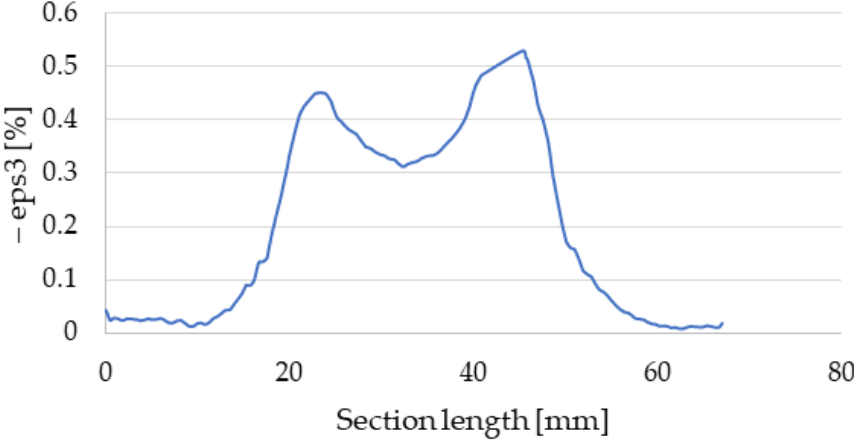
Figure 16. S2 Thickness reduction values with P7/SC2 combination.